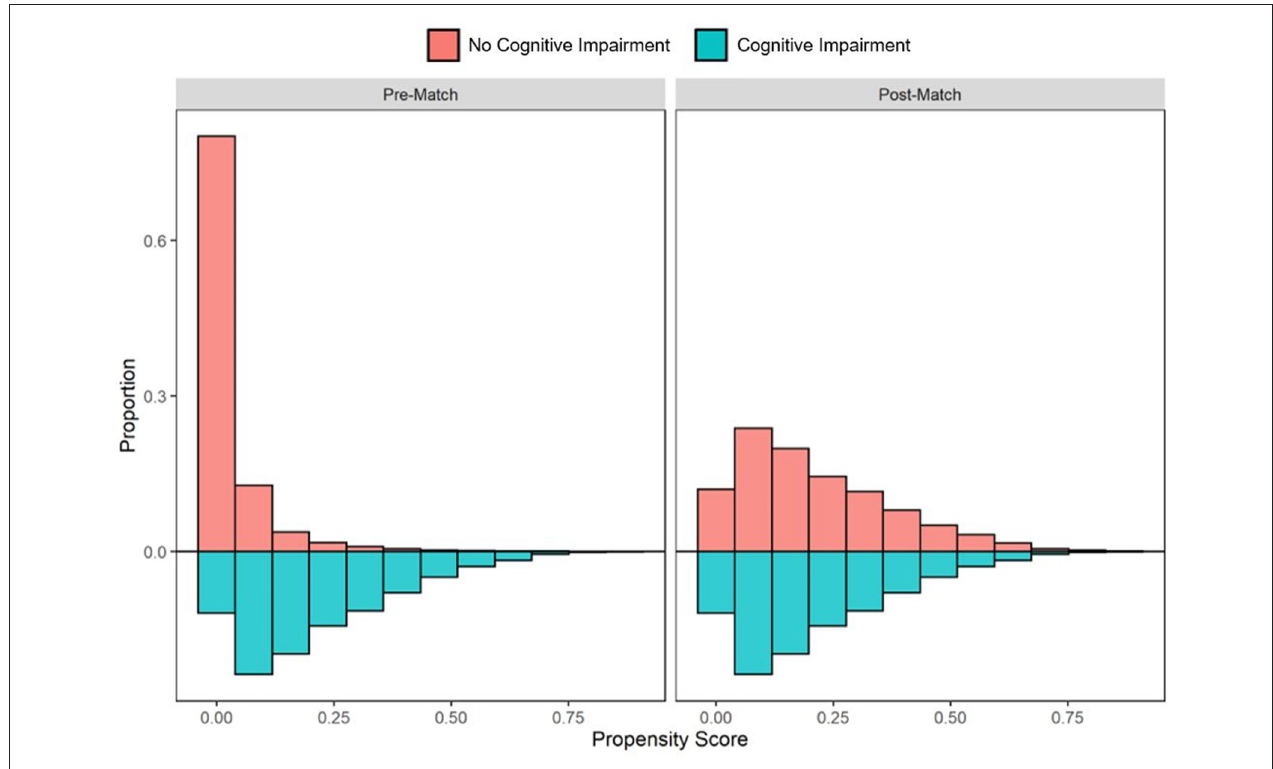
FIGURE 4 | Pre- and post-matched distribution of individual propensity scores among SARS-CoV-2 tested individuals, by preexisting cognitive impairment status. Cohort proportions ( Y -axis) by propensity score ( X -axis) are presented. Cohorts matched on age, sex, race, ethnicity, marital status, insurance coverage, area deprivation index (ADI), obesity, diabetes, hypertension, and overall Charlson Comorbidity Index